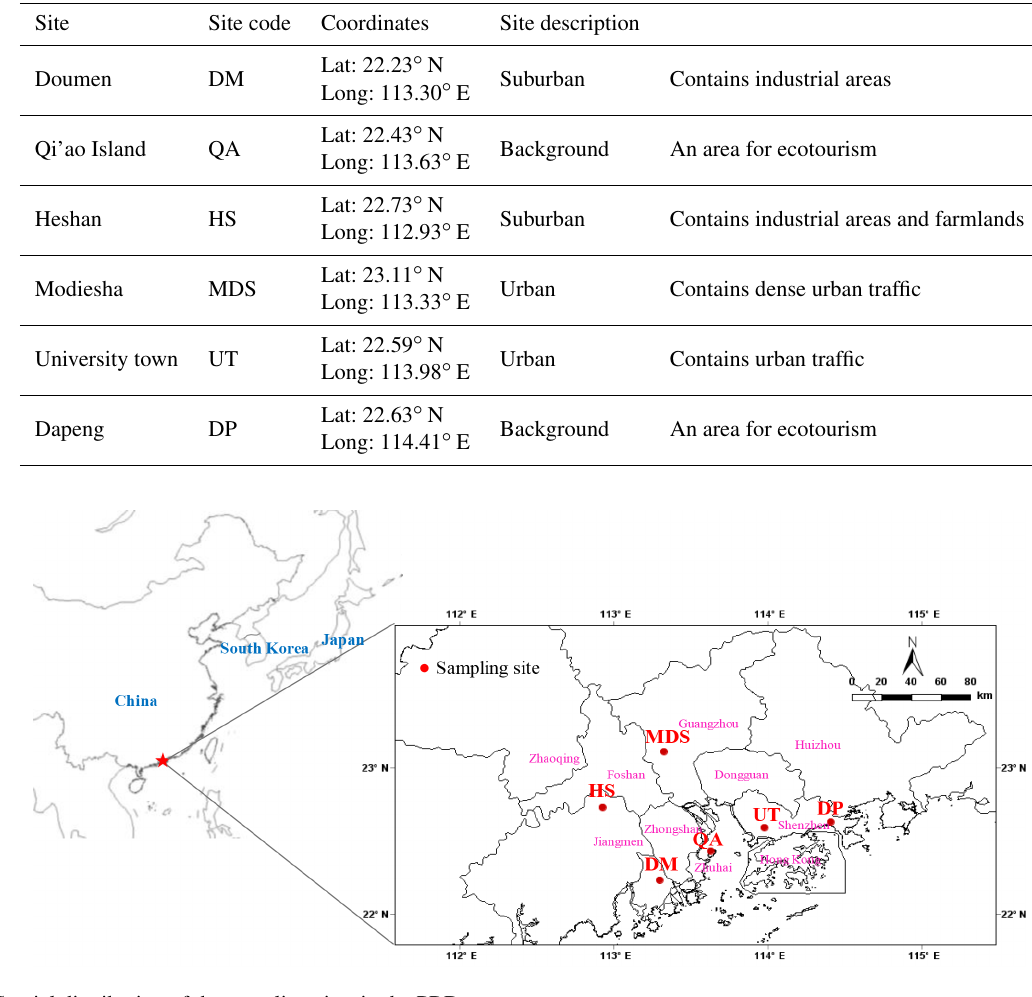
Figure 1. Spatial distribution of the sampling sites in the